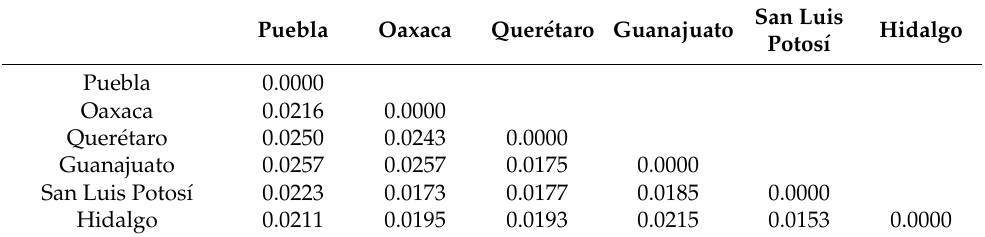
Table 3. Pairwise population matrix of FST based in Nei (1972) genetic distance for six wild popula- tions of Brickellia